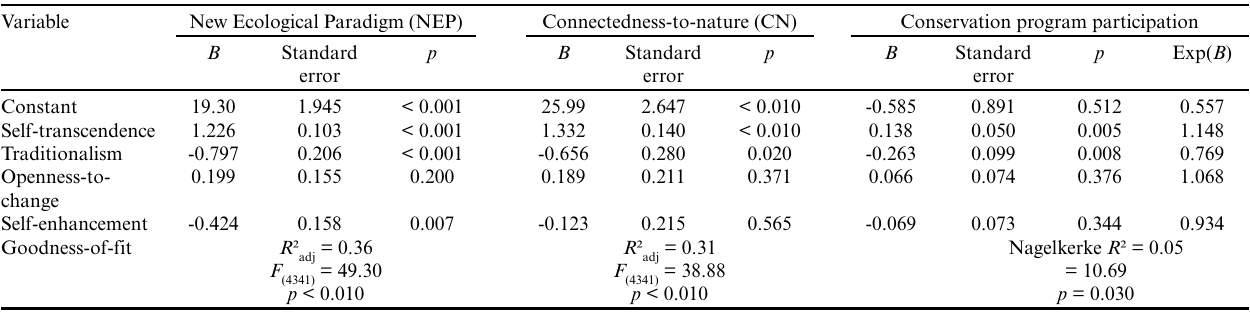
Table 3 . Regressions of worldviews and conservation program participation on four basic value dimensions.